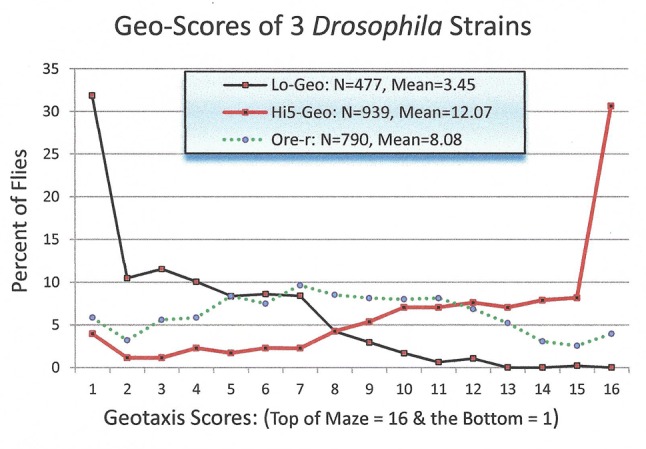
The distribution of D. melanogaster Hi5 and Lo geotaxis strains, and the Oregon-R (Ore-R), unselected, wild-type strain, in a 15-choice geo-maze. Flies finishing in exit tube “1” made 15 downward (geo-positive choices) and flies in tube “16” made 15 upward (geo-negative) choices. Lo and Hi5 distributions were significantly different (X21 = 507.2, p<0.001). The Ore-R data are included to illustrate the radical effect selection has had on the two selected, geotaxis strains. We can assume Ore-R’s response in the maze is similar to the strain Hirsch began working with in 1958.